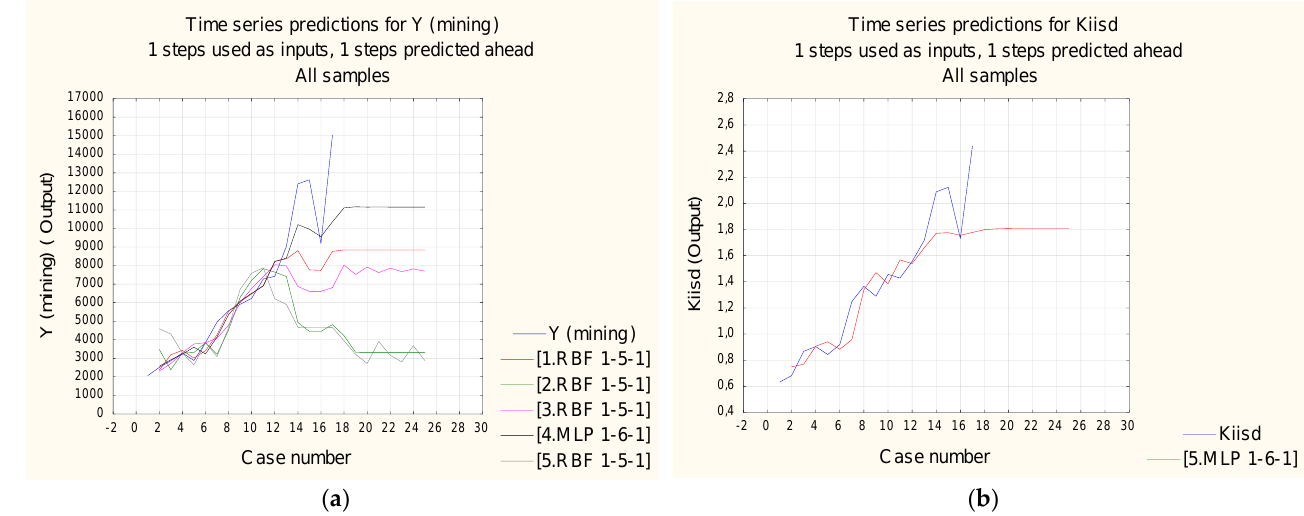
Figure 5. Projection the performance of innovative industrial systems 7 years ahead: ( a ) forecasting neural networks Y mining ; ( b ) K iis forecasting neural networks.